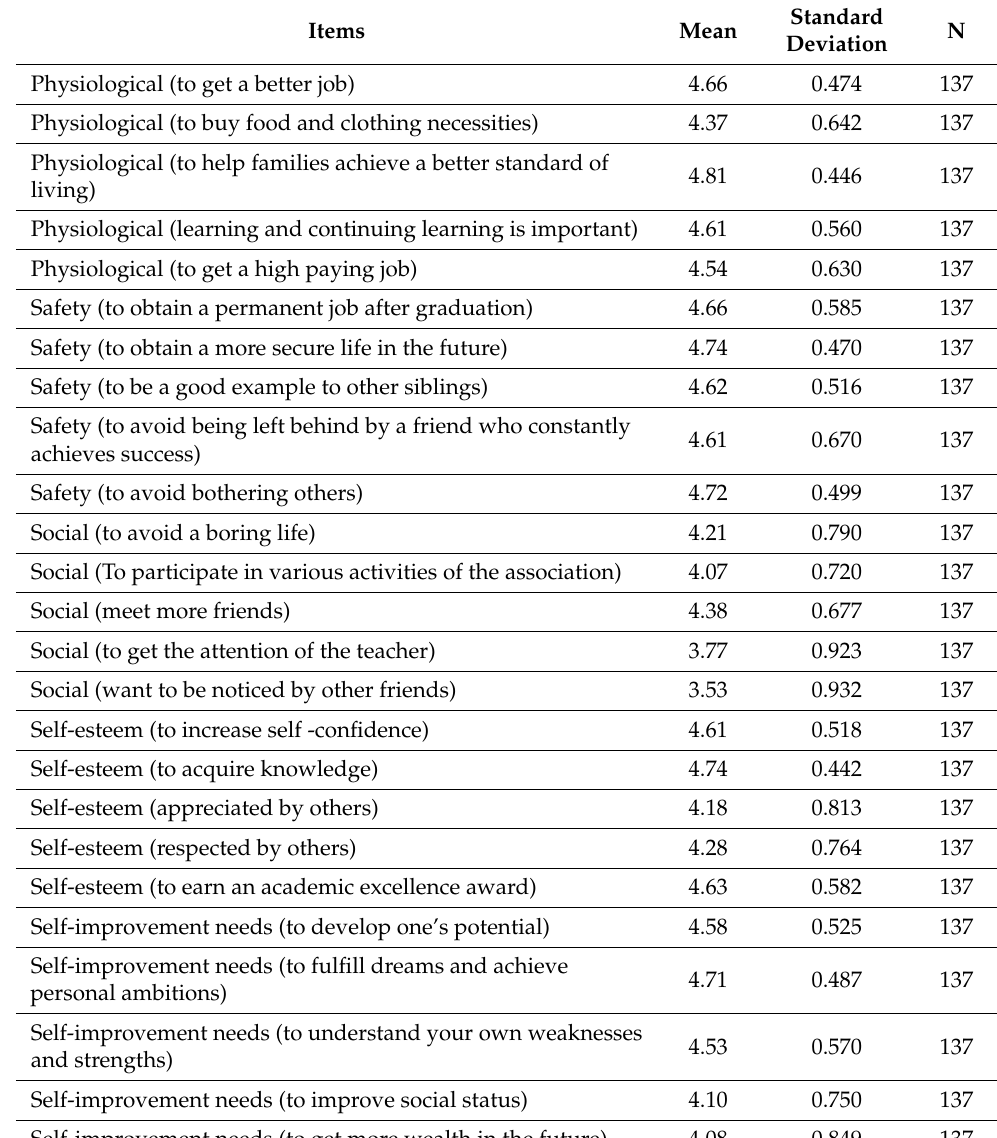
Table 2. Motivation Aspects of Students in Secondary School in